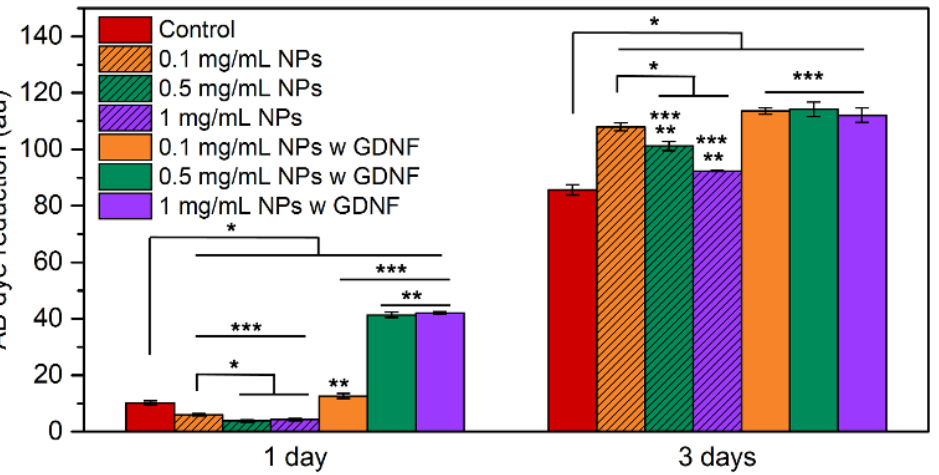
Figure 5. Viability AB results of iSCs in the presence of SCs cultured with CMCht/PAMAM NPs